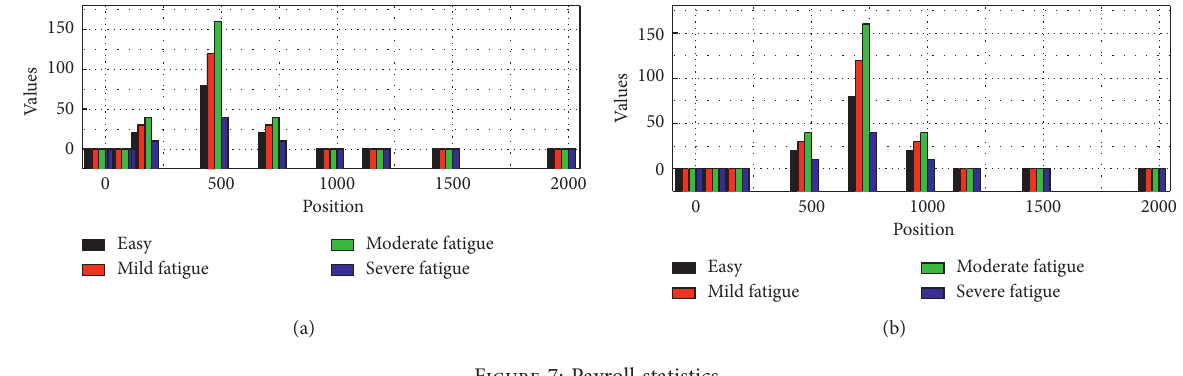
Figure 7: Payroll